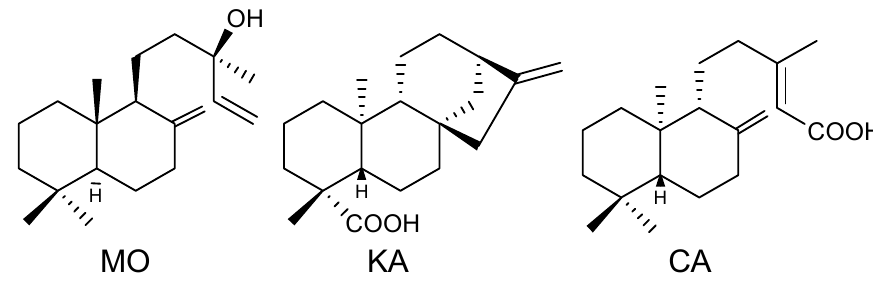
Figure 1. Chemical structures of the isolated diterpenes: manool (MO), ent- kaurenoic acid (KA), and ent- copalic acid